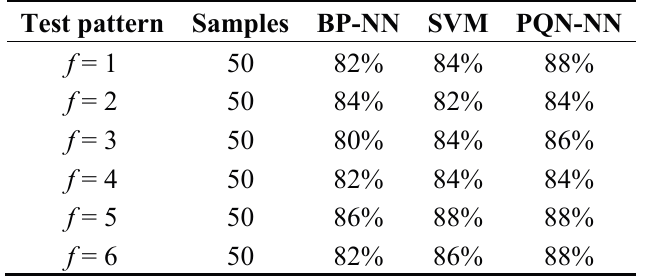
Table 3. Testing accuracy of BP-NN, SVM and PQN-NN.